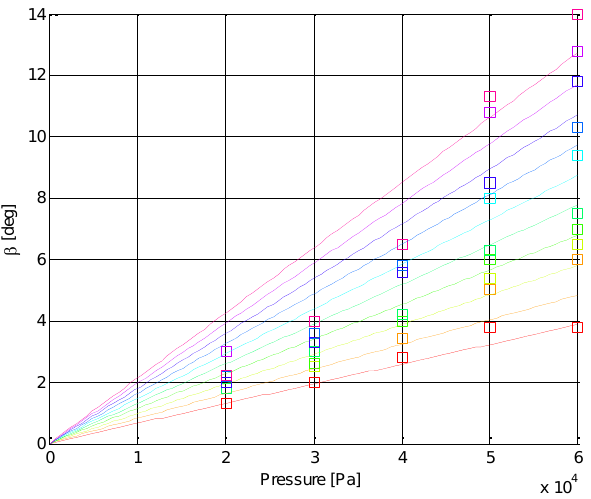
Figure 5. Static pressure response of prototype 1. Each color corresponds to each hinge (of a specified head angle). Squares mark the experiment, while lines represent the theoretical linear response.